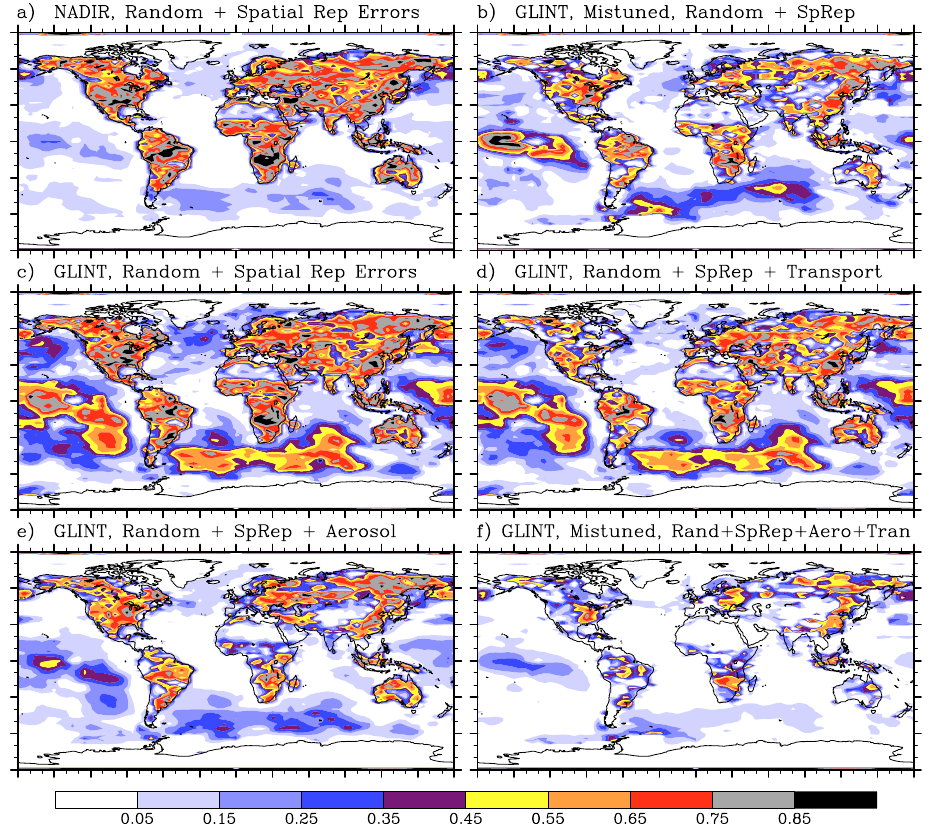
Fig. 9. Fractional error reductions in seasonal CO 2 fluxes, computed from the RMS of the four seasonal values (JFM, AMJ, JAS, OND) for experiments: (a) #1, (b) #3, (c) #2, (d) #4, (e) #5, and (f) #6, as in Fig.